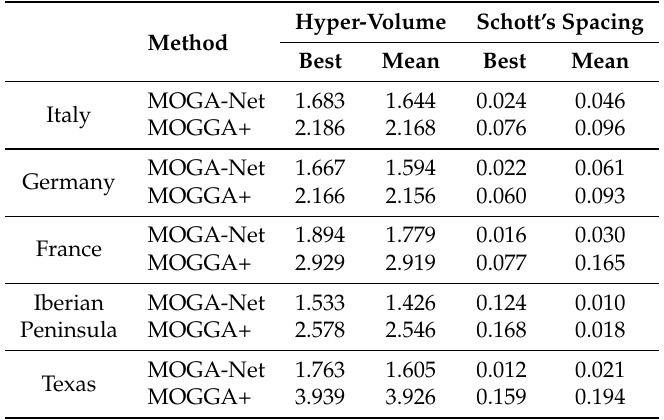
Table 3. Results obtained by Multi-objective Genetic Algorithm for Networks (MOGA-Net) and MOGGA+ considering the modularity and imbalance objectives.